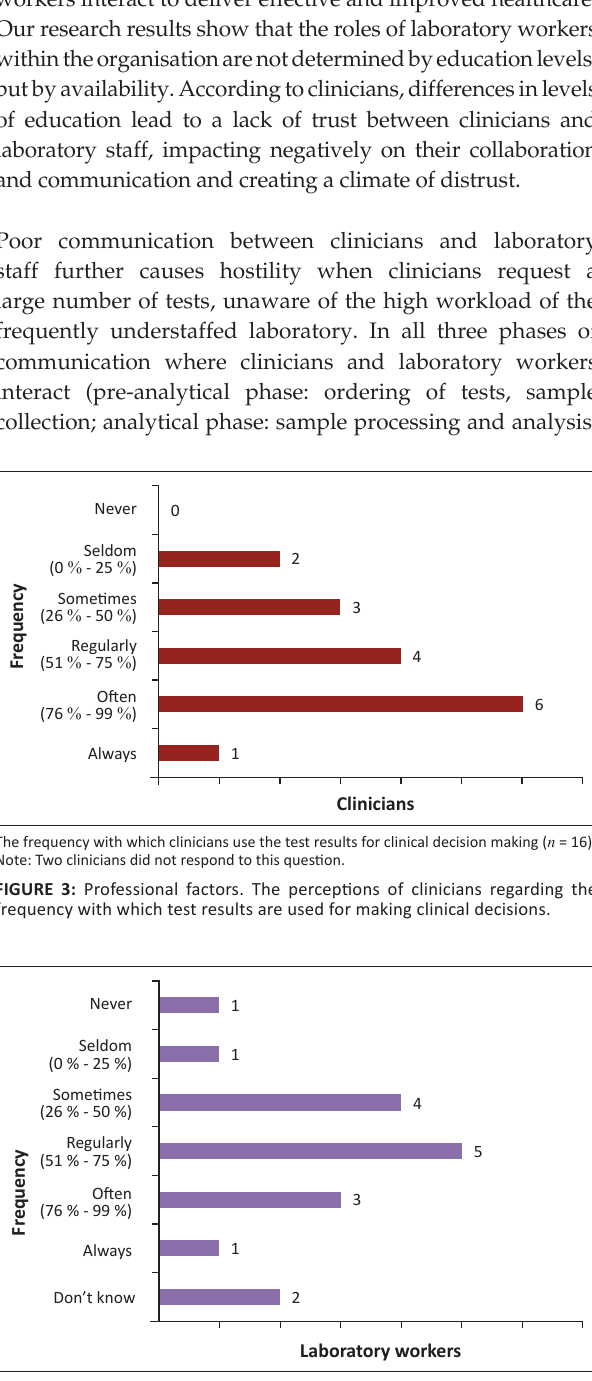
FIGURE 6: The frequency of professional contact between clinicians and laboratory workers. Eleven of 14 laboratory workers reported having daily professional contact with